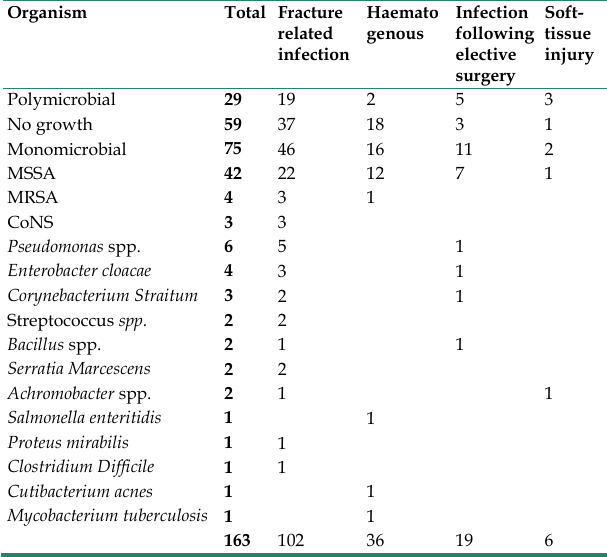
Table 4. The aetiology of infection and the microbiological results.